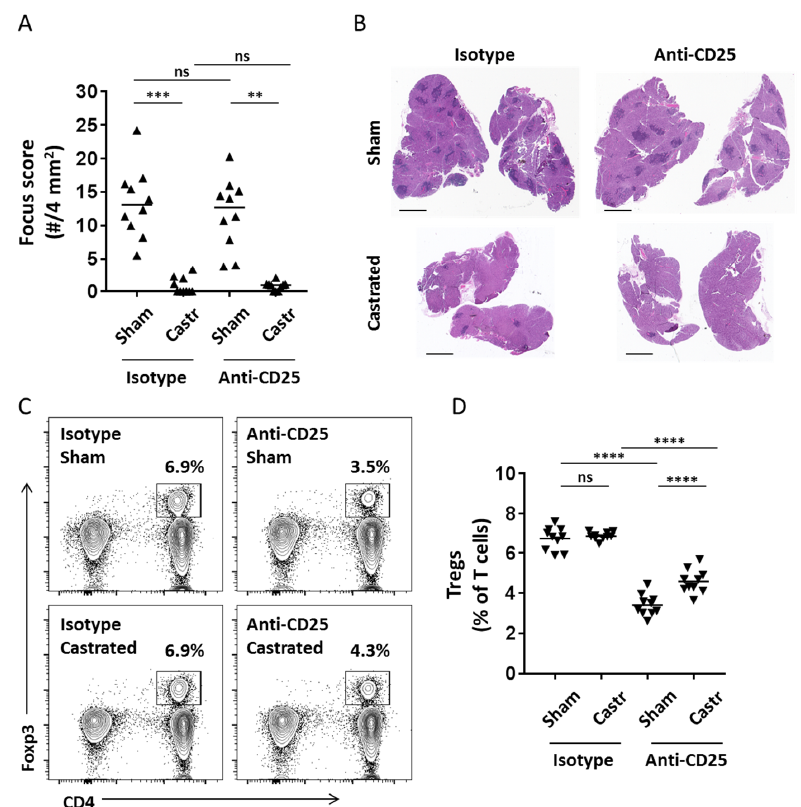
Figure 1. Treg-depletion is not sufficient to drive dacryoadenitis in castrated male NOD mice. ( A ) Quantitation of dacryoadenitis in castrated (Castr) or Sham-castrated (Sham) mice treated with Treg-depleting anti-CD25 antibody or isotype control (10 mice per group). Focus score equals # inflammatory foci per 4 mm 2 , where a focus requires a minimum of 50 mononuclear cells. Symbols represent individual mice, lines are medians. p < 0.0001 by Kruskal-Wallis with individual